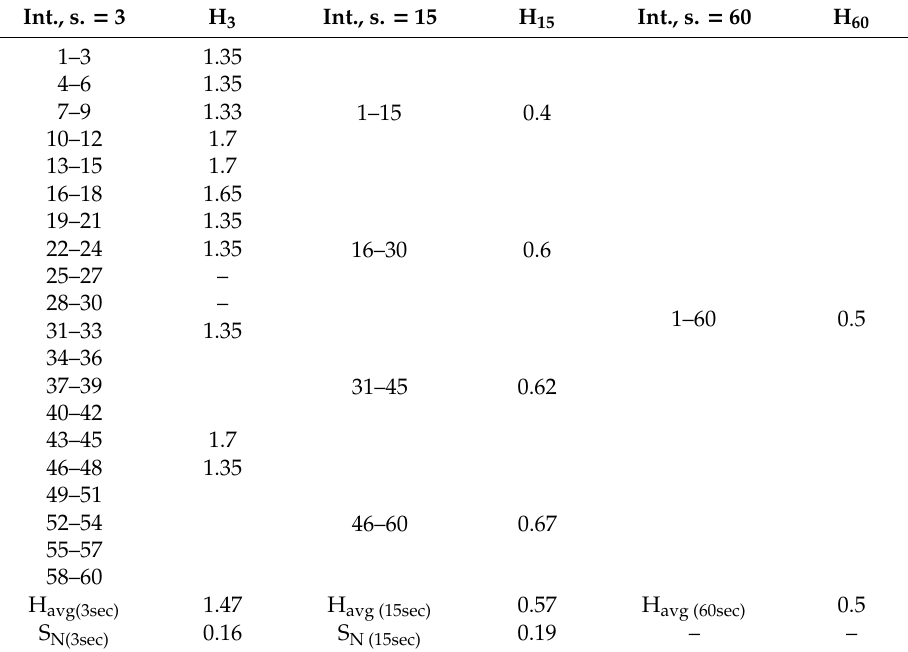
Table 2. Subscriber tables for TCP packets of web tra ffi